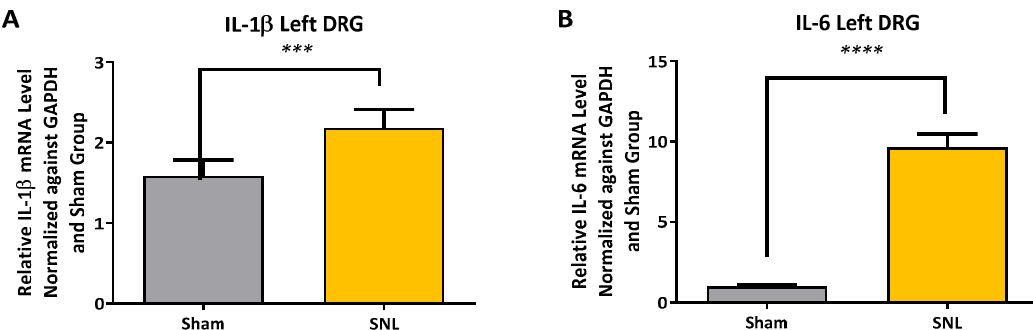
Figure 3. MMP2 ( A ) and MMP9 ( B ) mRNA expression levels in ipsilateral DRG for sham and SNL vehicle groups. MMP-2 mRNA expression levels were found to be significantly elevated after SNL- surgery while MMP-9 mRNA was found to be not significant. Data presented as the average from n = 10 per group ± SEM and analyzed with a two-tailed unpaired t-test (ns, not significant; ****, p < 0.0001).